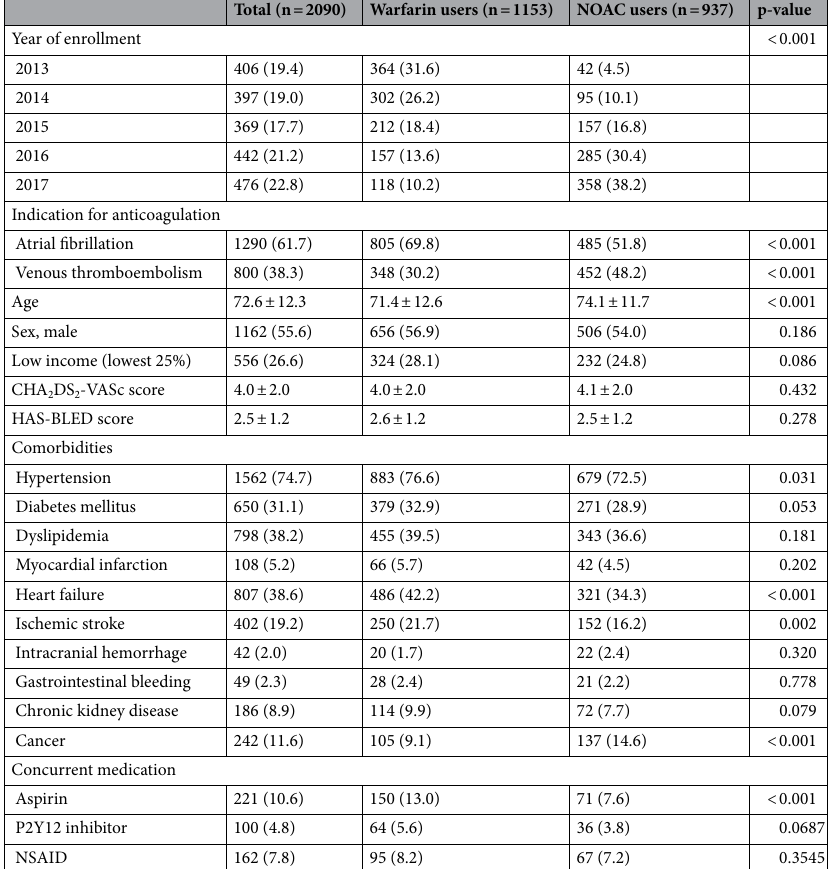
Table 1. Baseline characteristics of the study population. NSAID non-steroidal anti-inflammatory drug.